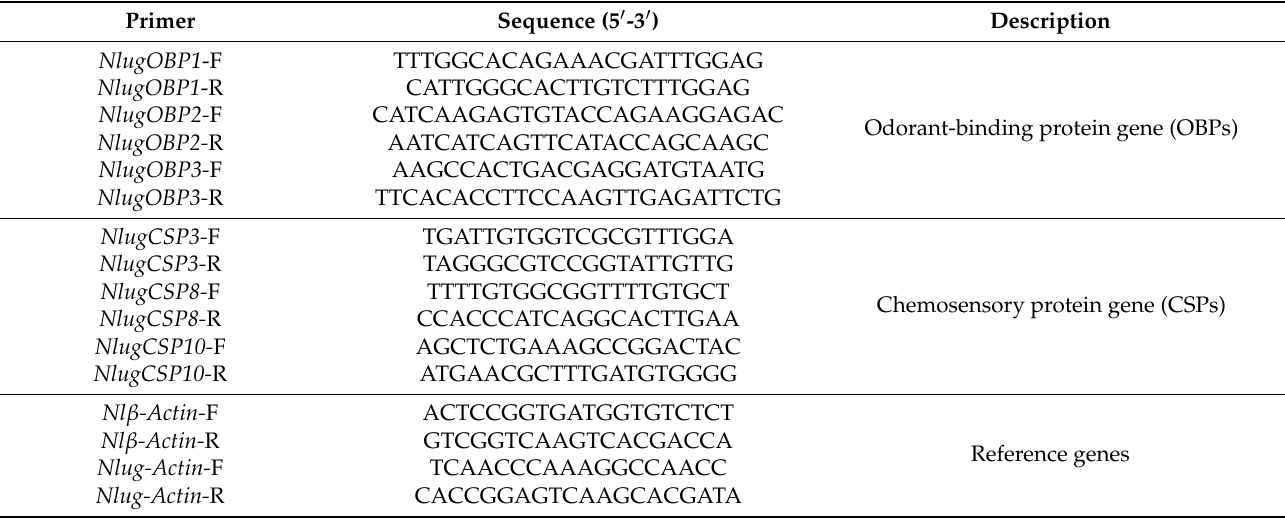
Table 1. QRT-PCR primers for the odorant-binding protein genes ( OPB1 , OBP2 and OBP3 ), chemore- ceptor protein genes ( CSP3 , CSP8 and CSP10 ) and internal reference genes ( Nl β -Actin and Nlug-Actin ) of brown planthopper (BPH), Nilaparvata lugen